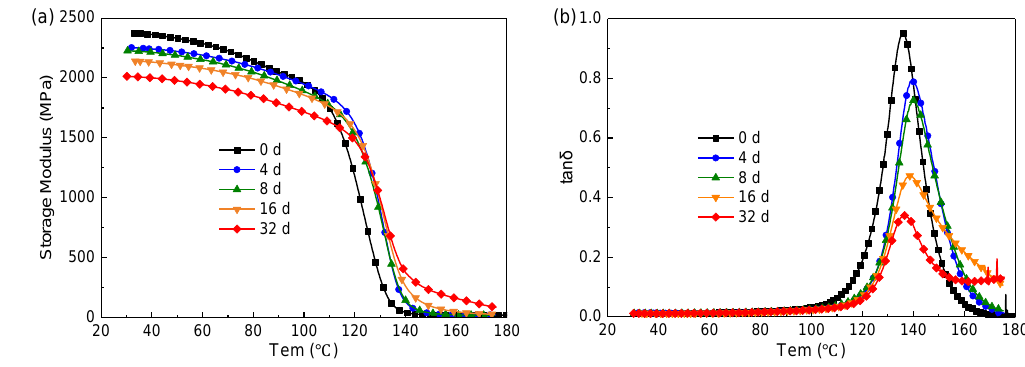
Figure 7. Dynamic thermomechanical behaviors. ( a ) storage modulus; ( b ) loss factor.